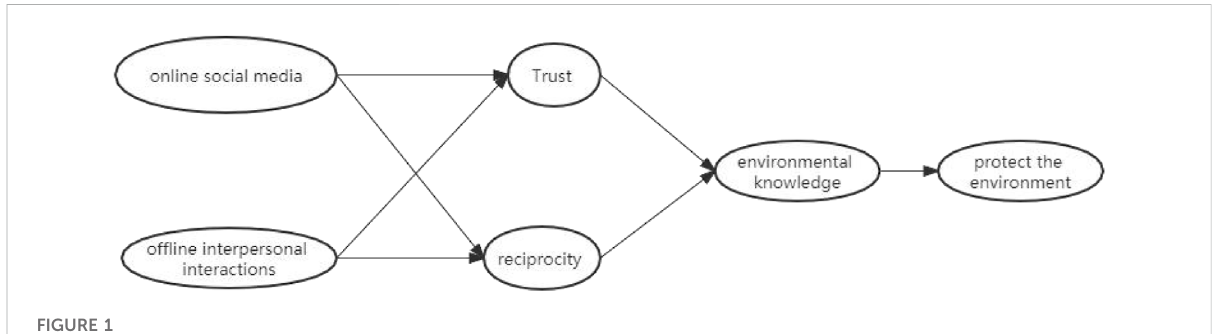
FIGURE 1 Diagram of the model for this